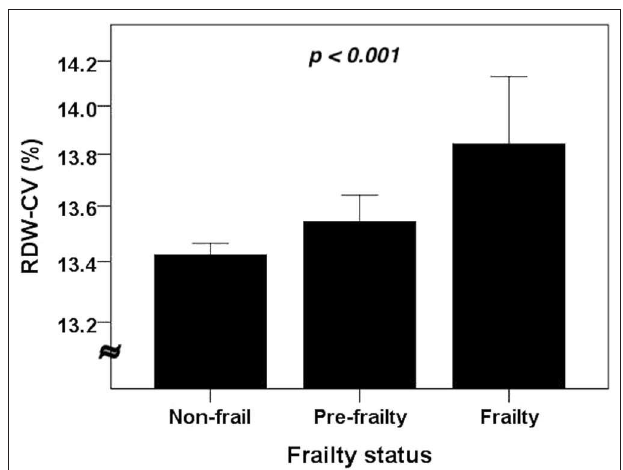
FIGURE 1 | The RDW levels among older adults without and with different severities of frailty ( n = 2,932). Compared using the analysis of variance (ANOVA). CV, coefficient of variation; RDW, red cell distribution width.